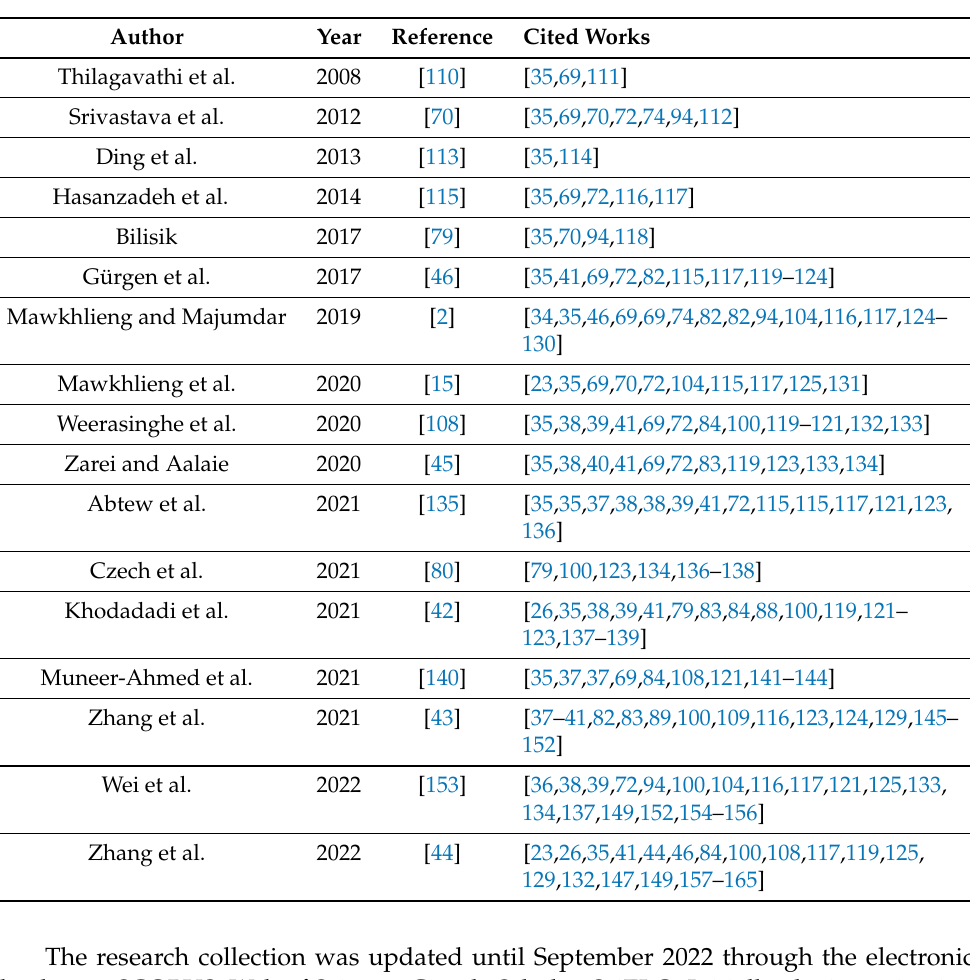
Table 5. Review works screened and read for report selection.